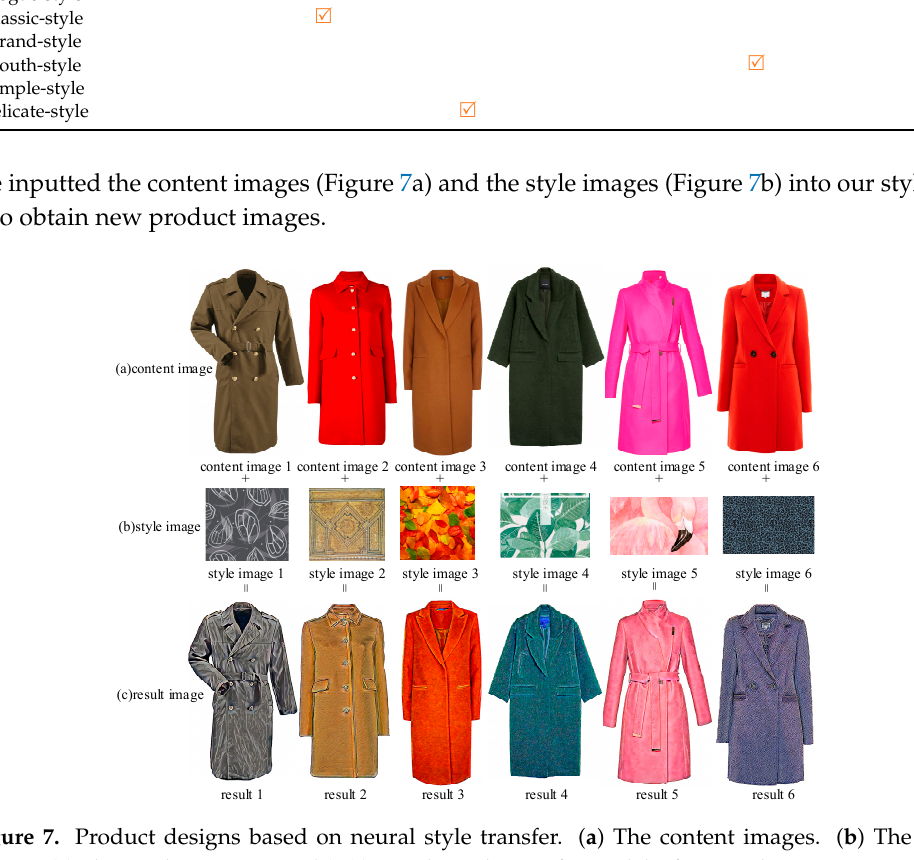
Table 4. Image style evaluation results.